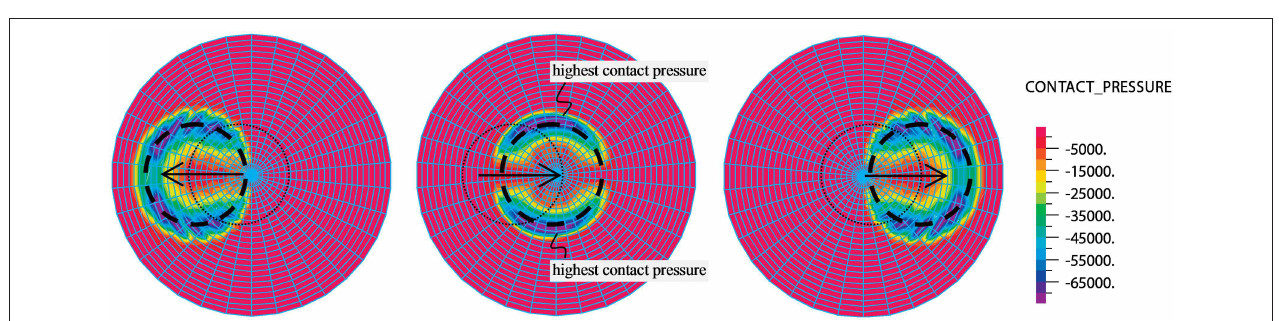
FIGURE 10 | Temperature measurements of the eight thermocouples for test #5 (Top) and test #8 (Bottom) .